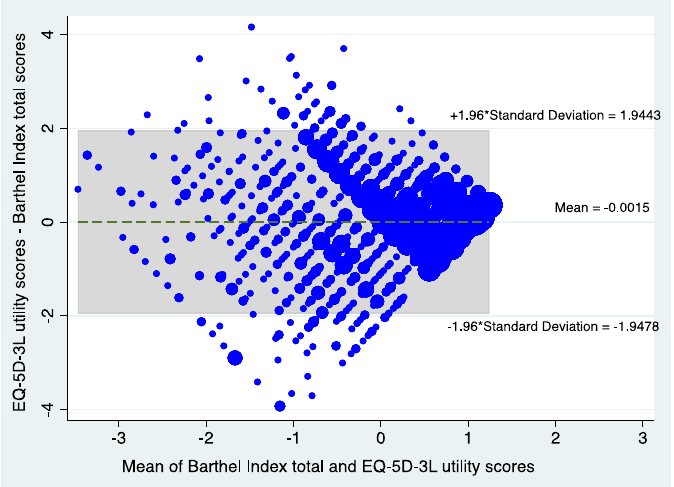
dimensions 3 levels (EQ-5D-3L) utility standardized Z scores versus Barthel index total standardized Z